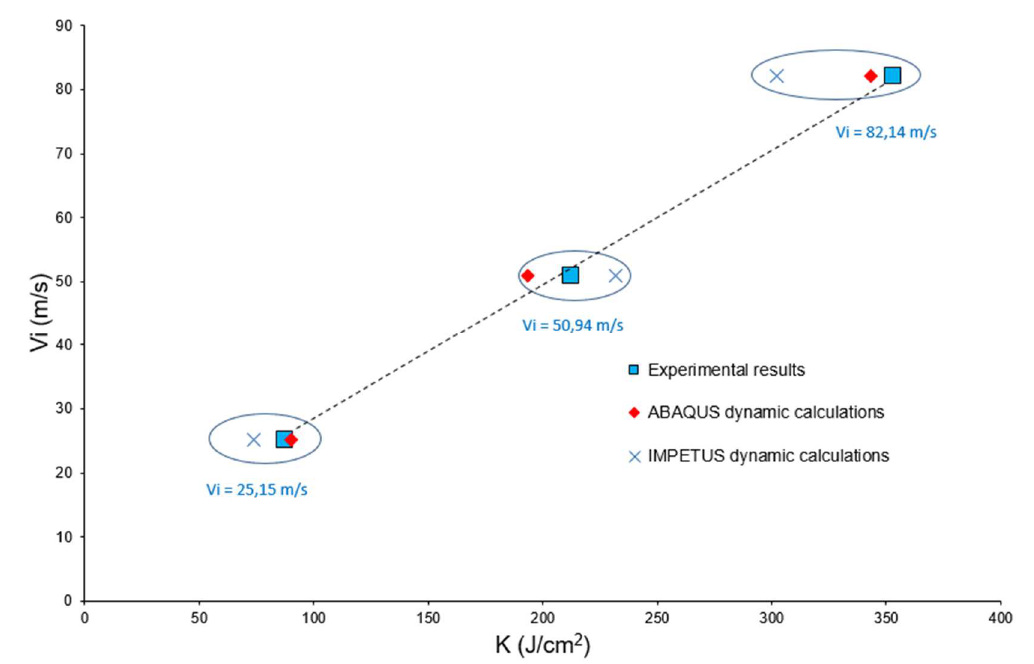
Fig. 9. Load versus displacement of the cross head for experimental and computing configurations.